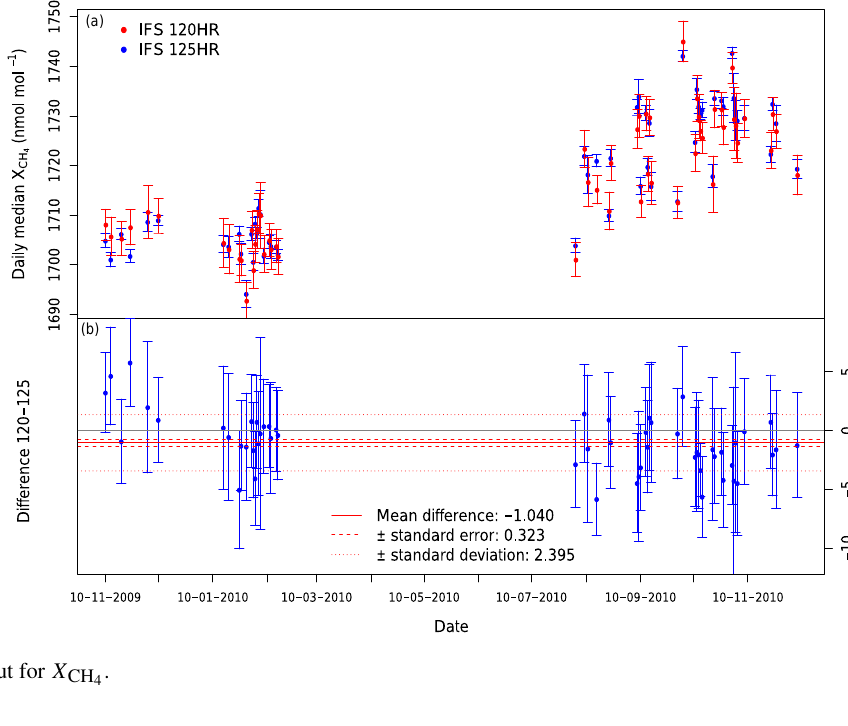
Figure 7. As Fig. 6 but for X CH